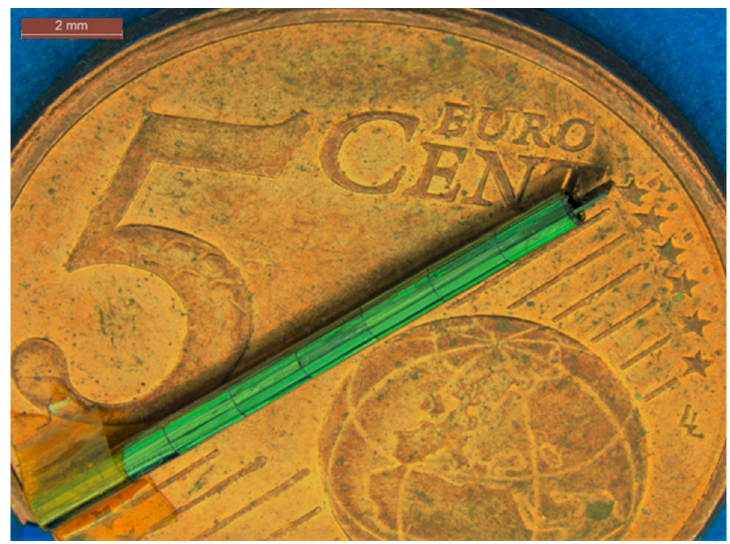
Figure 10. DBS demonstrator wrapped into a cylindrical probe with a length of 18 mm and a diameter of 1.2 µm.